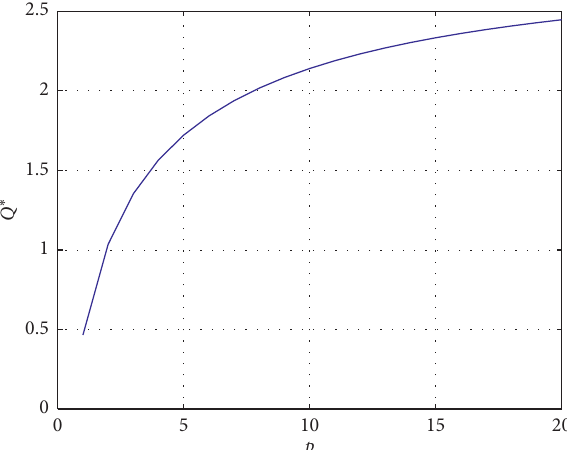
Figure 8: Effect of retail price p on the optimal inventory quantity r on the Q ∗ under RMI mode with stochastic demand in the water supply